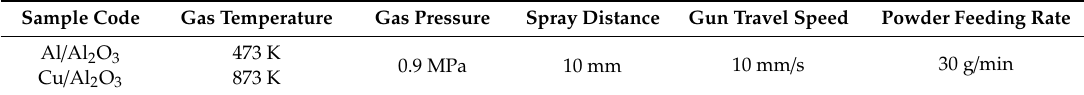
Figure 1. Feedstock powders used for metal matrix composite (MMC) coating deposition: ( a ) Al/Al 2 O 3 ( b ) Cu/Al 2 O 3 . Table 1. Spray parameters of low-pressure cold-sprayed composite coatings.